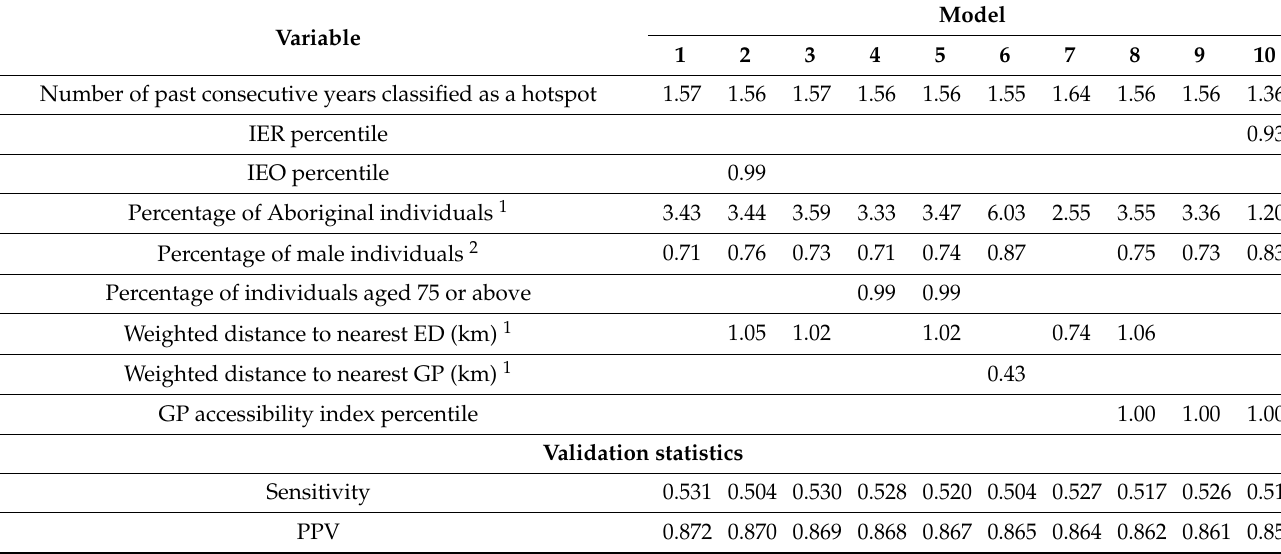
Table 2. Validation statistics for the ten best state-wide models for high-risk foot (HRF), with mean odds ratios for predictors in these